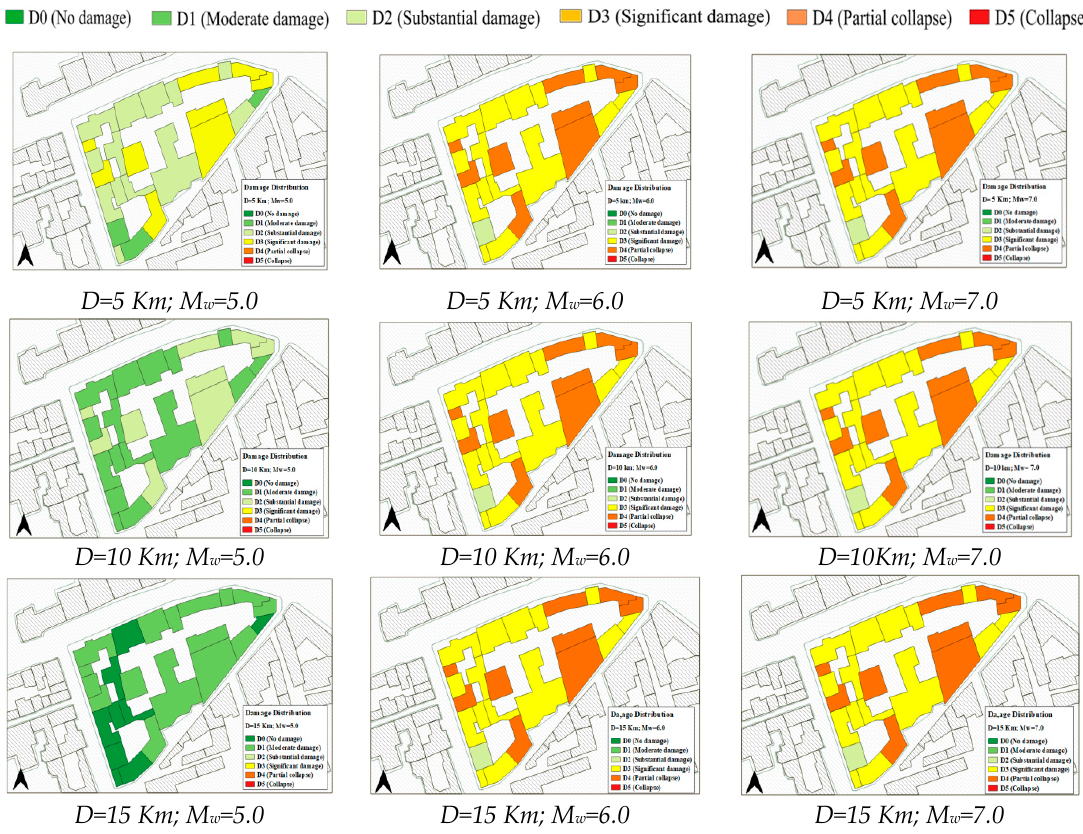
Figure 10. Damage scenarios of the investigated area within the historical centre of Qualiano.